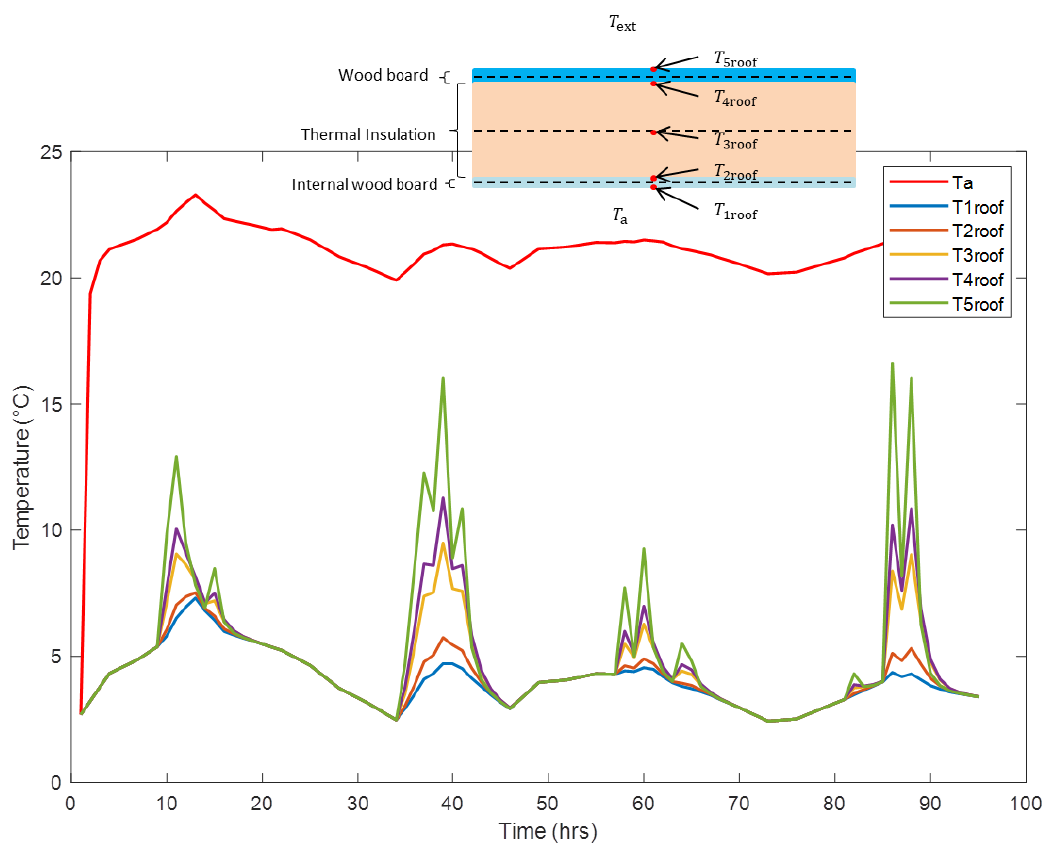
Figure 7. Temperature dynamics of the internal air and roof layers profiles.